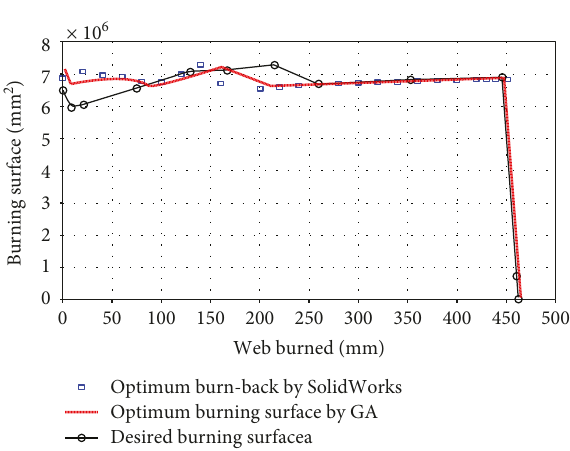
Figure 9: Comparing desired burning surface vs. web-burned & optimum burning surface vs. the web-burned from ABFC &